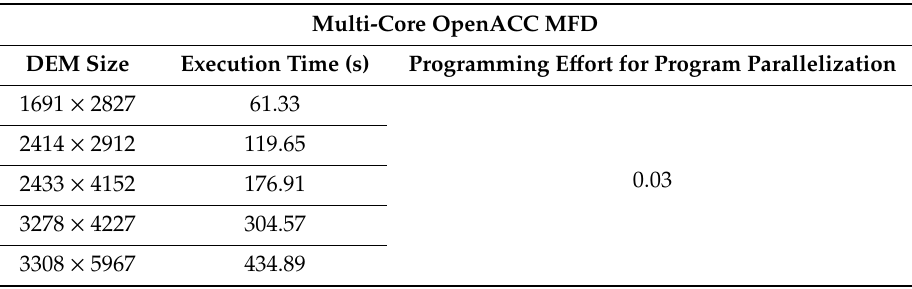
Table 2. Experimental results for Multicore-OpenACC